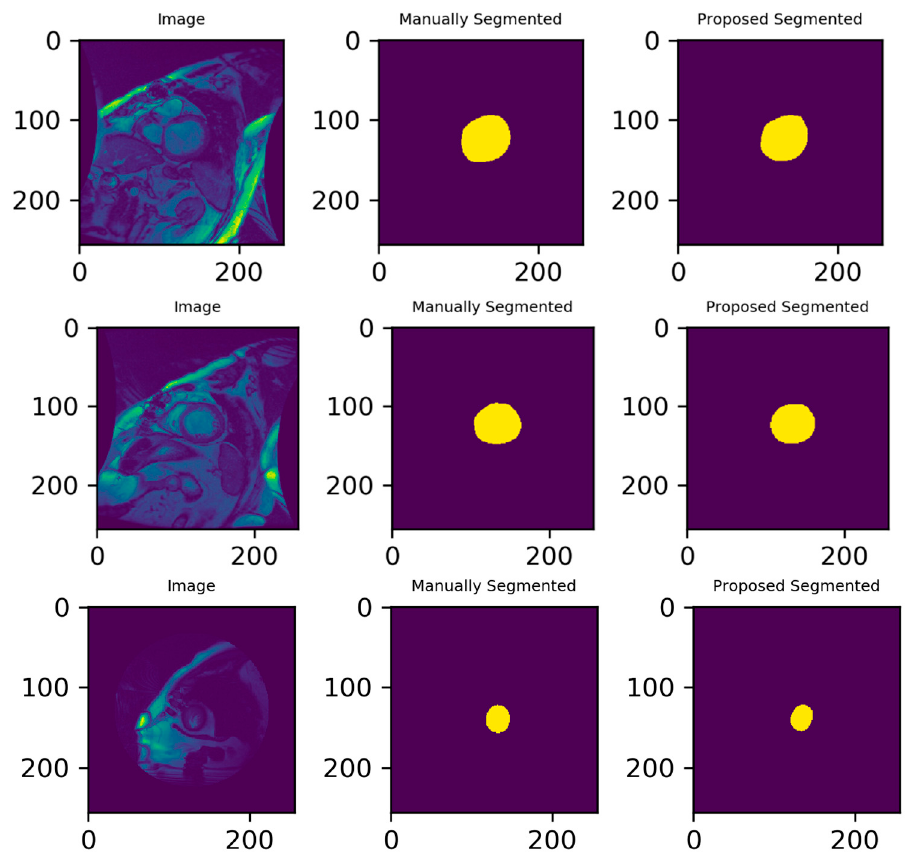
Figure 11. Input images from the SC-HF, SC-HF-I, and SC-HYP test samples and the predicted segmented mask or contour along with manual contour.